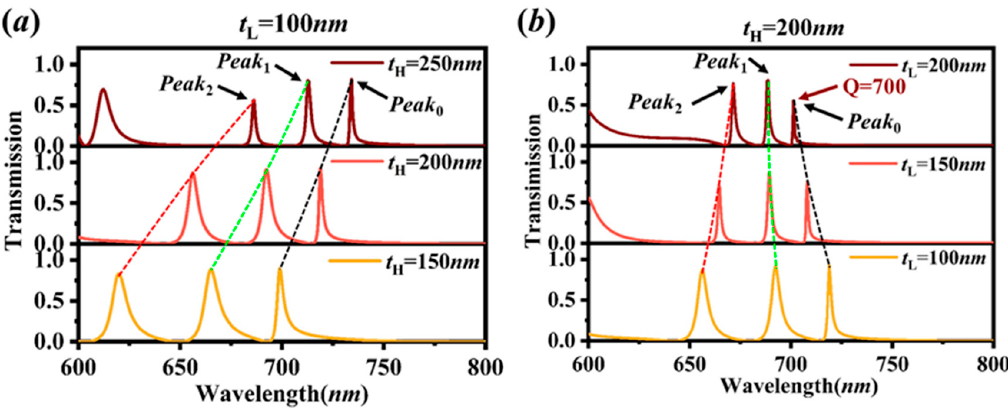
Figure 6. ( a ) and ( b ) Transmission spectra of the proposed structure (